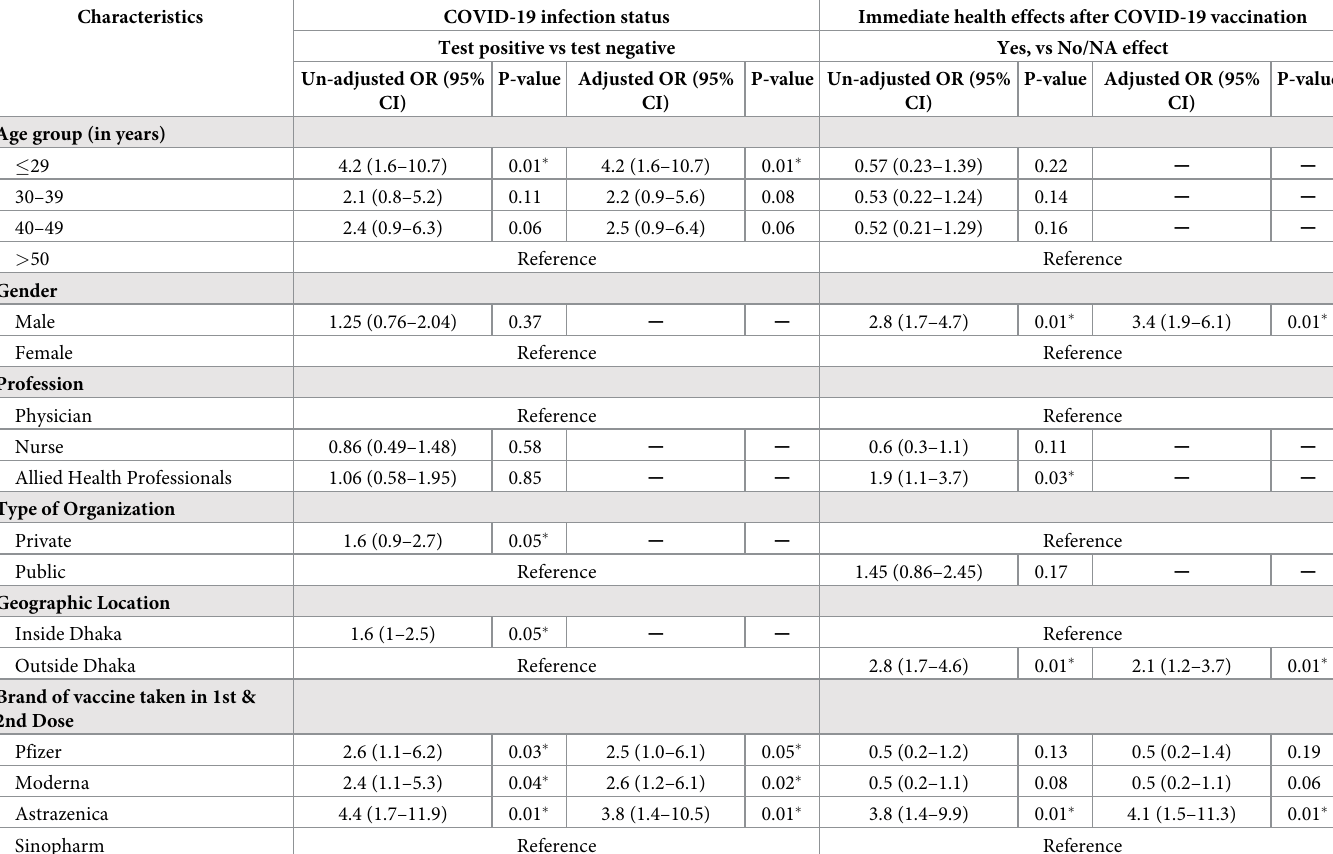
Table 2. Predictors associated with the COVID-19 infection status and side effects of vaccination among the respondents (n = 300).